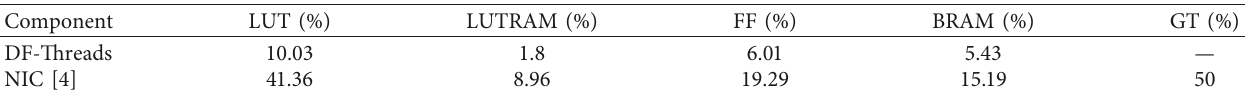
Figure 16: Two AXIOM boards interconnected up to 18Gbps via inexpensive USB-C cables. The AXIOM board is based on a Xilinx Zynq Ultrascale +ZU9EG platform, four high-speed ports (up to 18Gbps), an Arduino socket, and DDR4 extensible up to 32 GiB. As can be seen from the picture, we do not need any external switch but just two simple USB-C cables to connect the two systems. Table 5: Resource utilization of the key components of the implemented programmable logic on ZU9EG FPGA (AXIOM board).